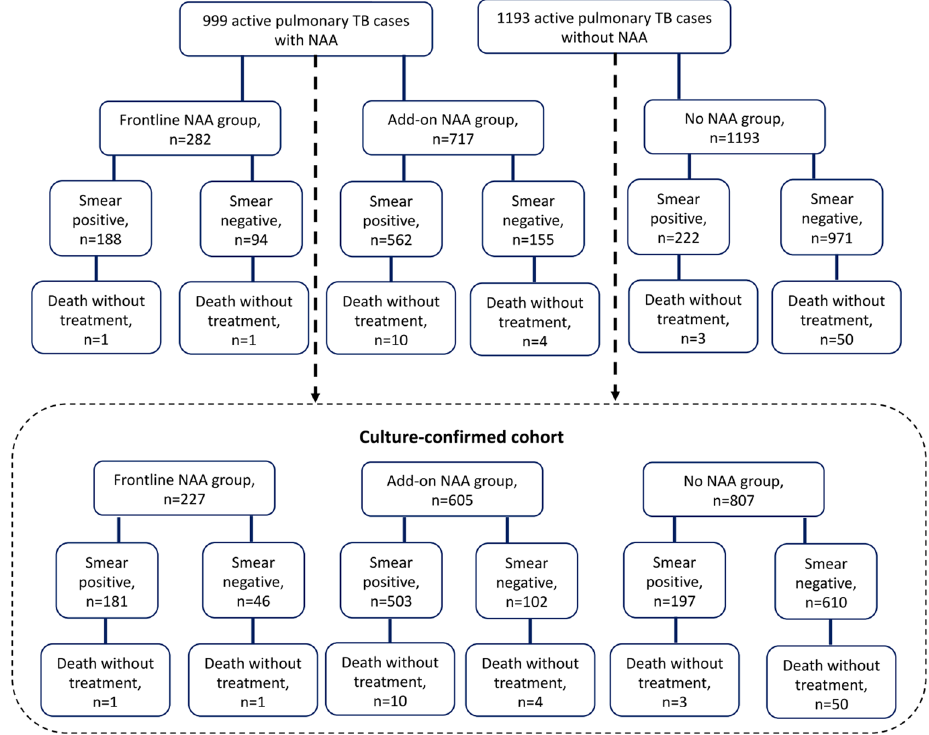
Figure 1. Study flow diagram and reasons for patient exclusion. NAA nucleic acid amplification.